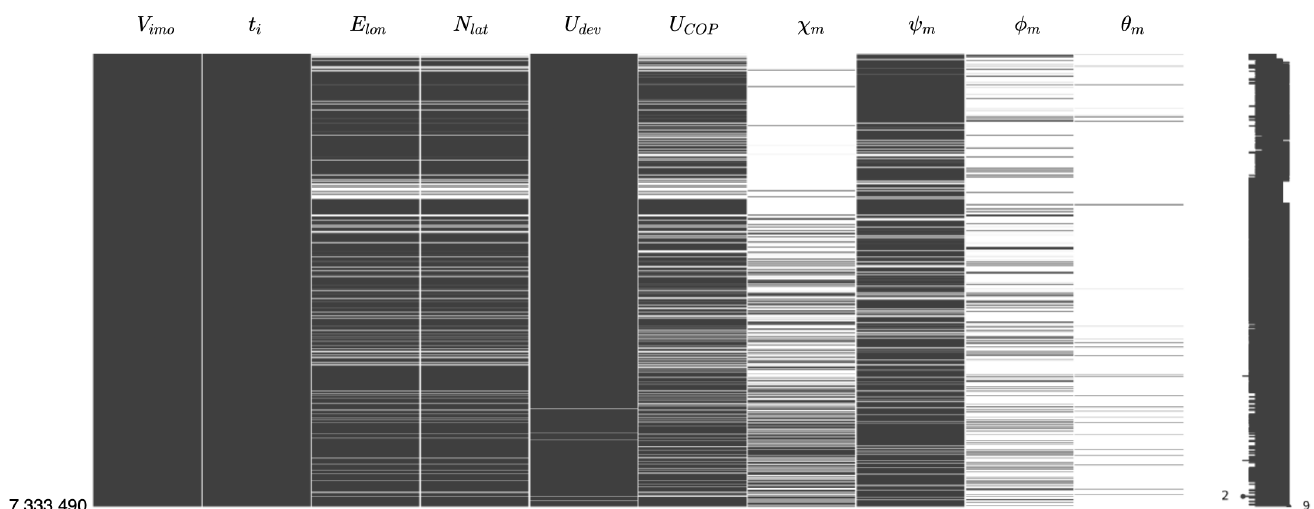
Figure 6. Missing data matrix for the principal features of the main